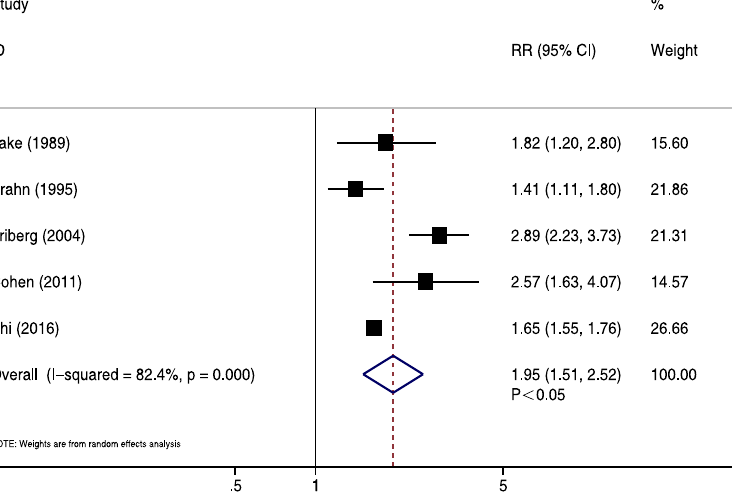
Figure 5. Forest plot showing the comparison between AF and non-AF patients in the pooled analysis of adjusted relative risk for cardiovascular mortality.